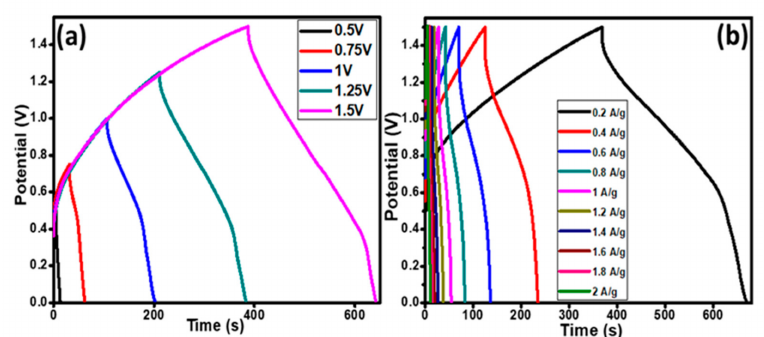
Figure 12. ( a ) Charge–discharge plots of the assembled device, Ag / Co 3 O 4 @PANI // AC supercapattery at di ff erent potentials at a current density of 0.2 A · g − 1 and ( b ) charge–discharge plots at di ff erent current densities ranging from 0.2 to 2.0 A · g − 1 at potential of 1.5